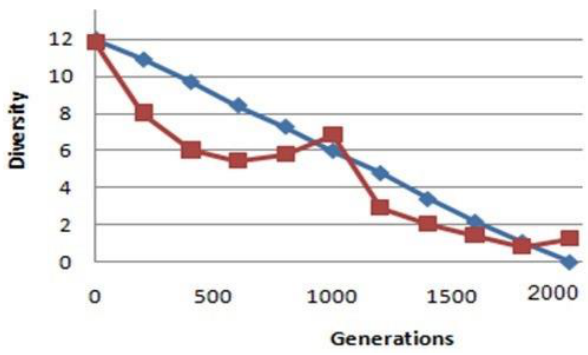
Figure 10. Diversity curve with ten (10) generations.